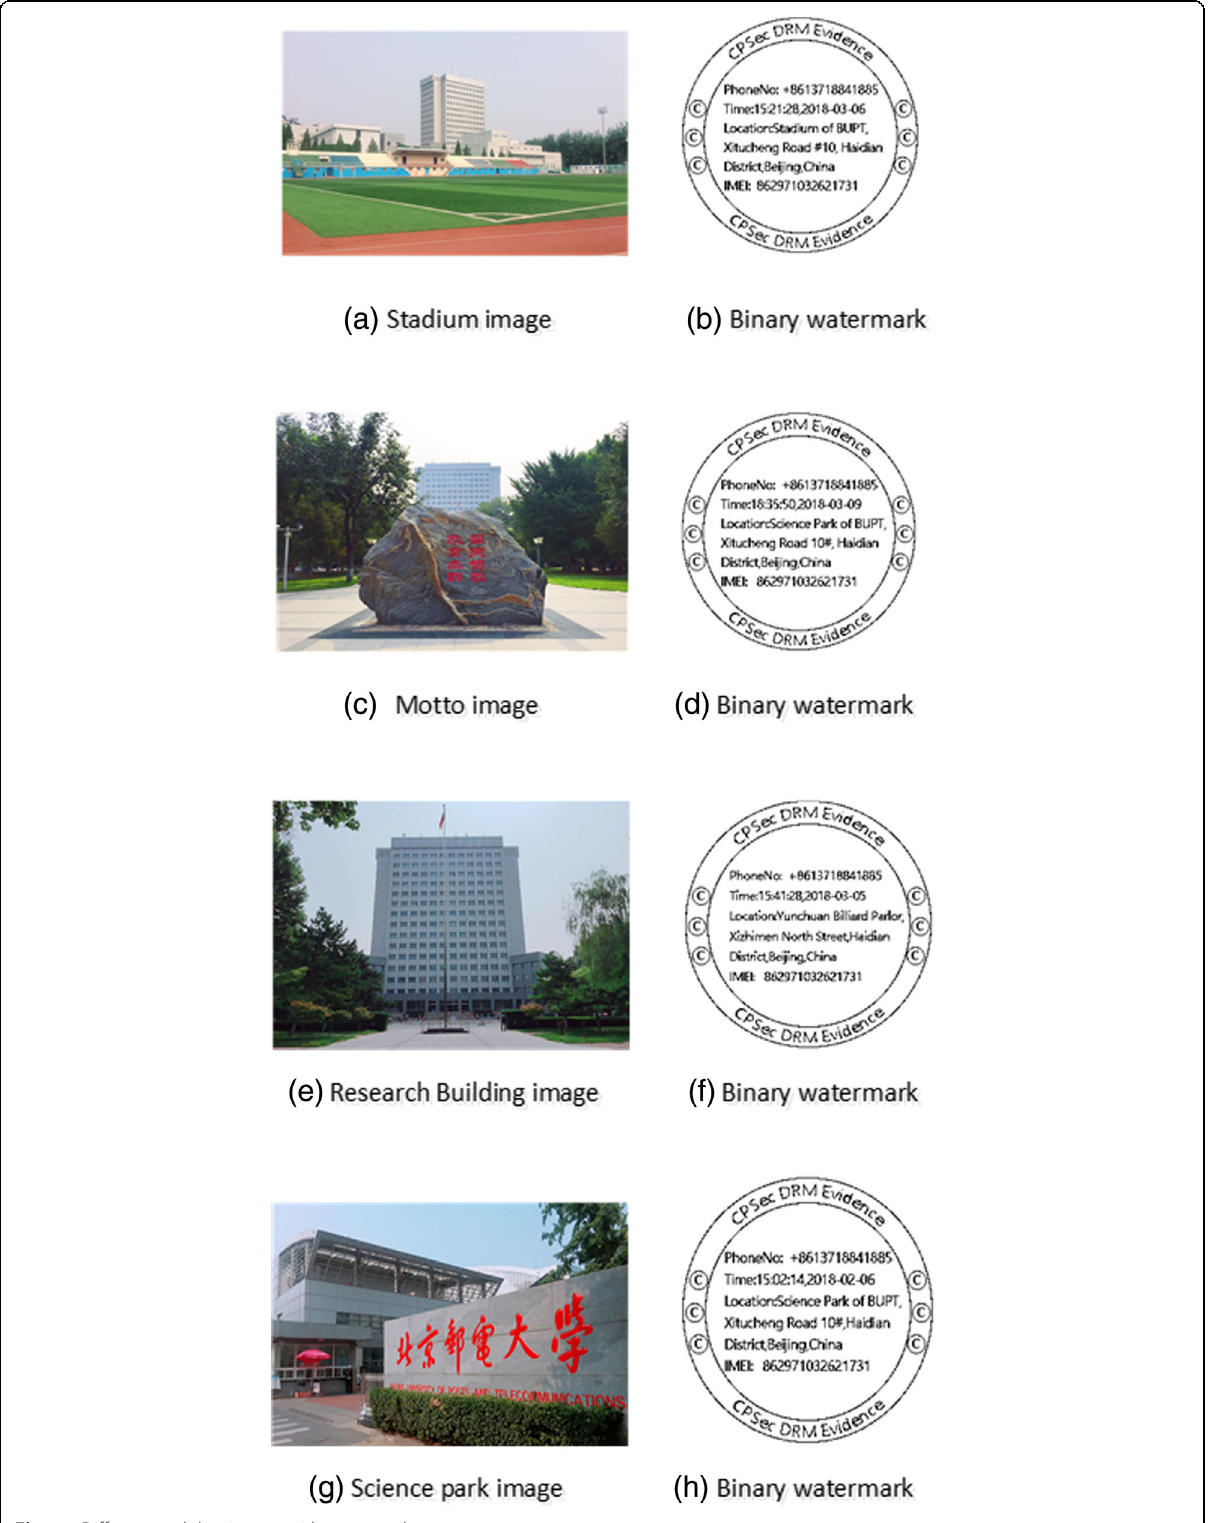
Fig. 11 Different mobile pictures with